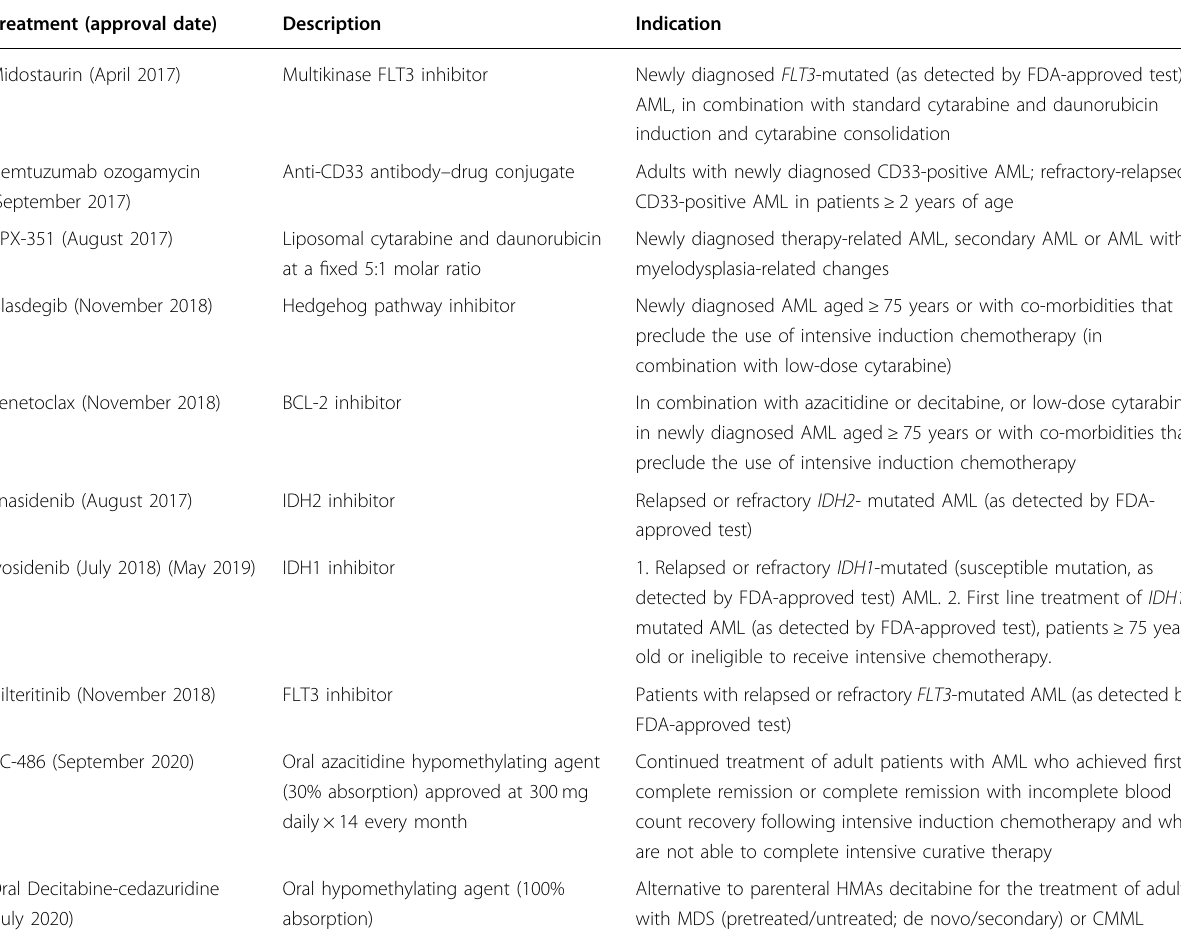
Table 1 Recent Food and Drug Administration Drug Approvals (since 2017) in acute myeloid